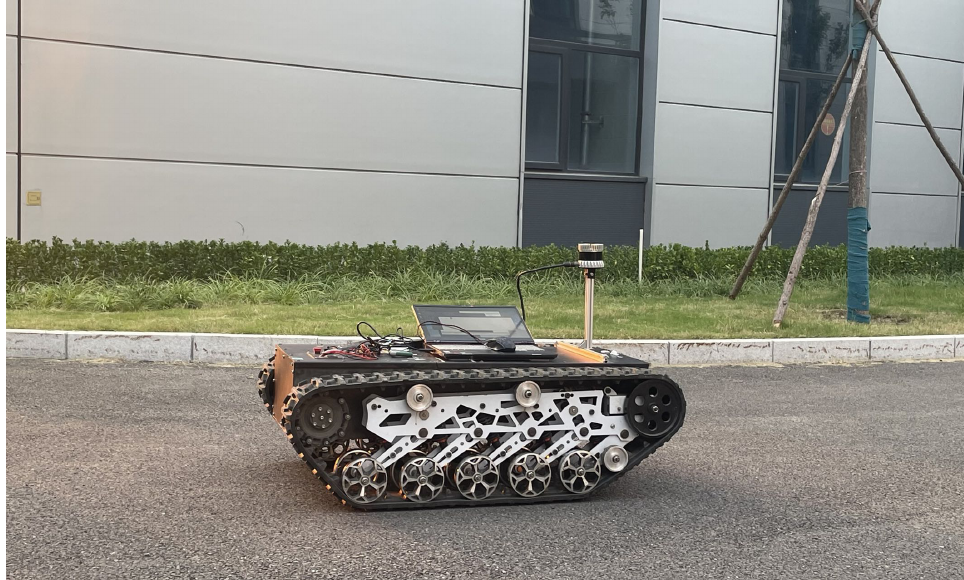
Figure 7. Tracked vehicles equipped with 64-line LiDAR.